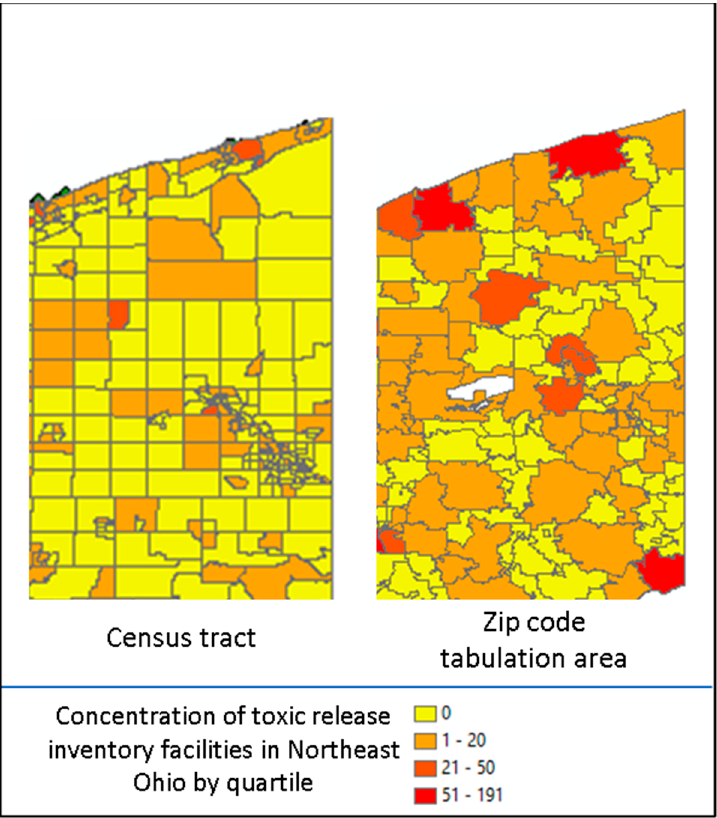
Figure 2. Example of Modifiable Area Unit Problem in Northeast Ohio.